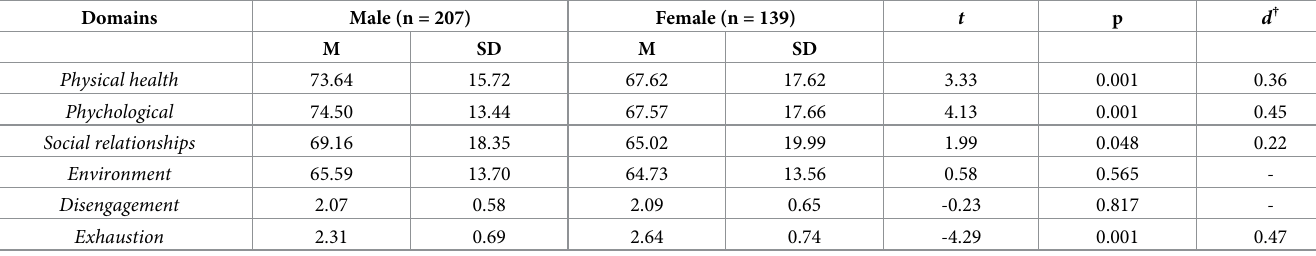
Table 2. Mean scores of quality of life and occupational burnout according to gender (n = 347). Domains